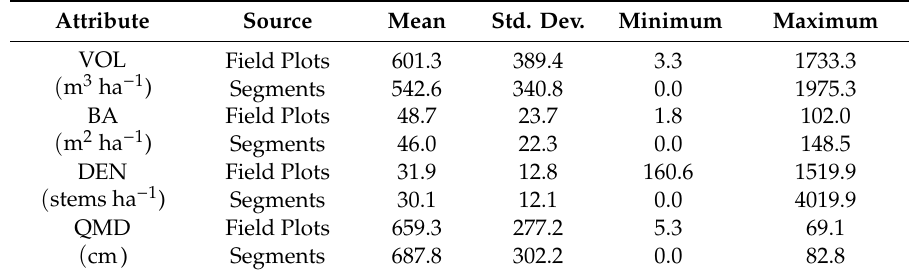
Table 3. Sample means, standard deviations, and ranges for forest inventory attributes for the sample of field plots and the sample of segments. Note: for the mean and the standard deviations, a weighted mean was calculated for each plot using segment and plot areas as weights, respectively, and means and standard deviations of these scaled observations are reported in the